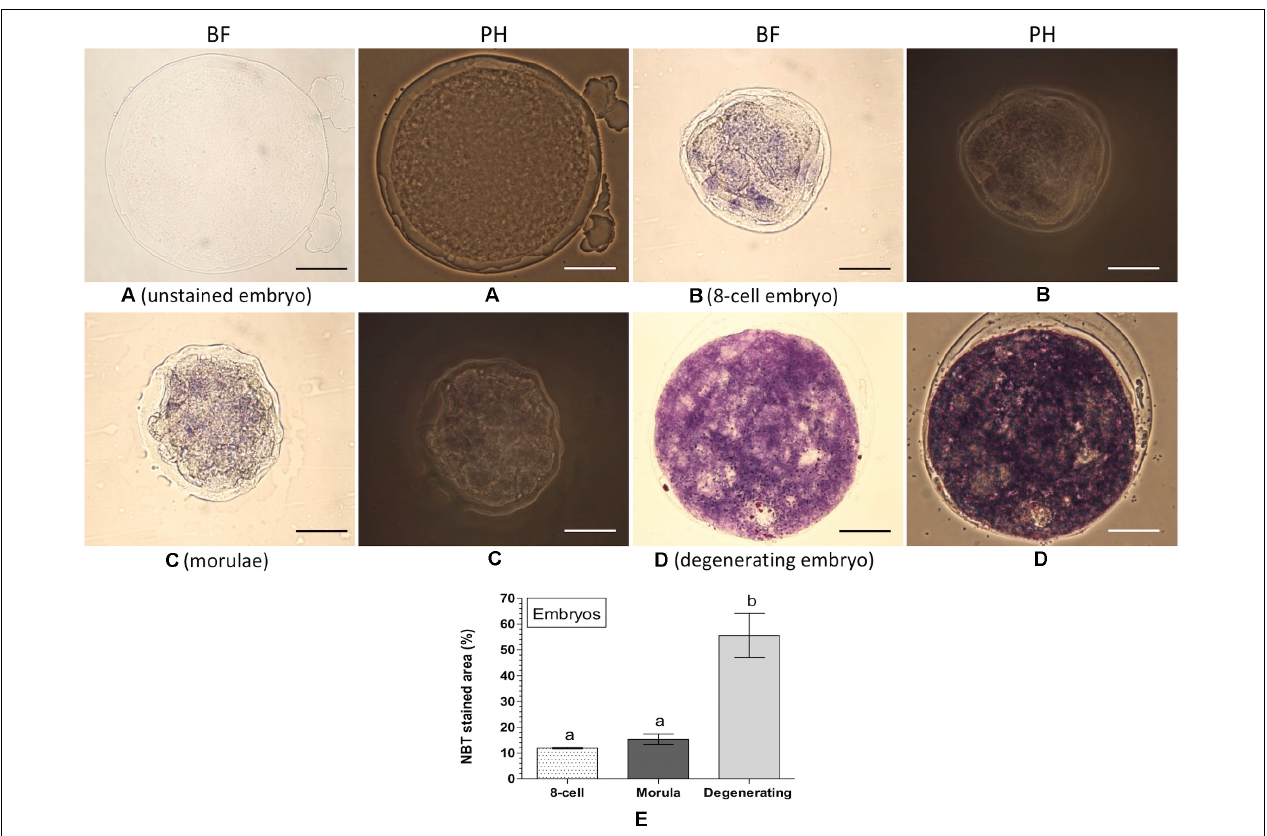
FIGURE 6 | Nitroblue tetrazolium (NBT) staining for assessing intracellular ROS in embryos. Ovine embryos (8-cell, morula and degenerating) were produced in vitro and stained with NBT. The dark purple/blue spots of formazan precipitates represent ROS. The level of intracellular ROS (% NBT stained area, mean ± SE) was determined in five individual embryos at each developmental stage. (A) Unstained degenerating embryo; (B) NBT-stained 8-cell embryo; (C) NBT-stained morulae; (D) NBT-stained degenerating embryo; (E) level of intracellular ROS in embryos at different developmental stages. Values without a common superscript (a, b) above error bar differ significantly ( P < 0.05). BF, bright-field image; PH, phase-contrast image. Scale bar = 50 µ